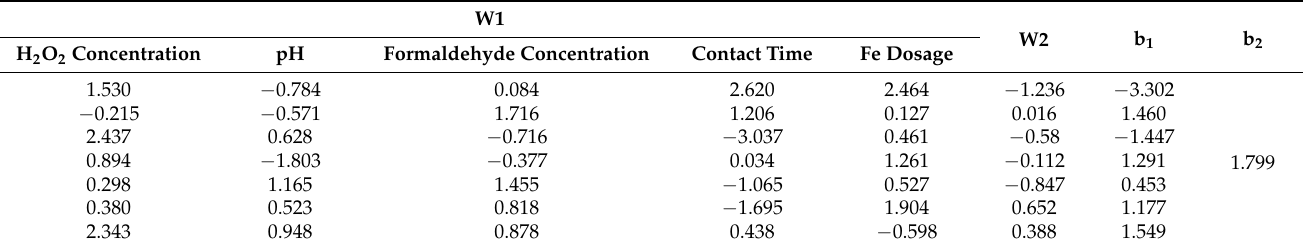
Table 6. The gained weights of the developed ANN models for formaldehyde removal from aqueous solutions by the Fenton